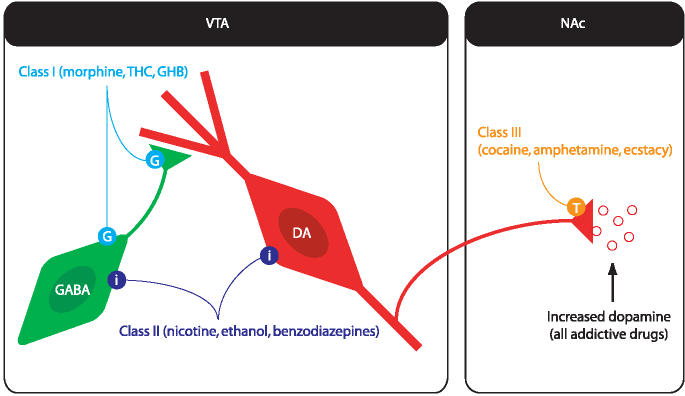
The Dominant Targets Involved in Increasing Dopamine for the Major Types of Addictive DrugsG, Gi/o-coupled receptors; i, ionotropic receptors/ion channels; T, monoamine transporters